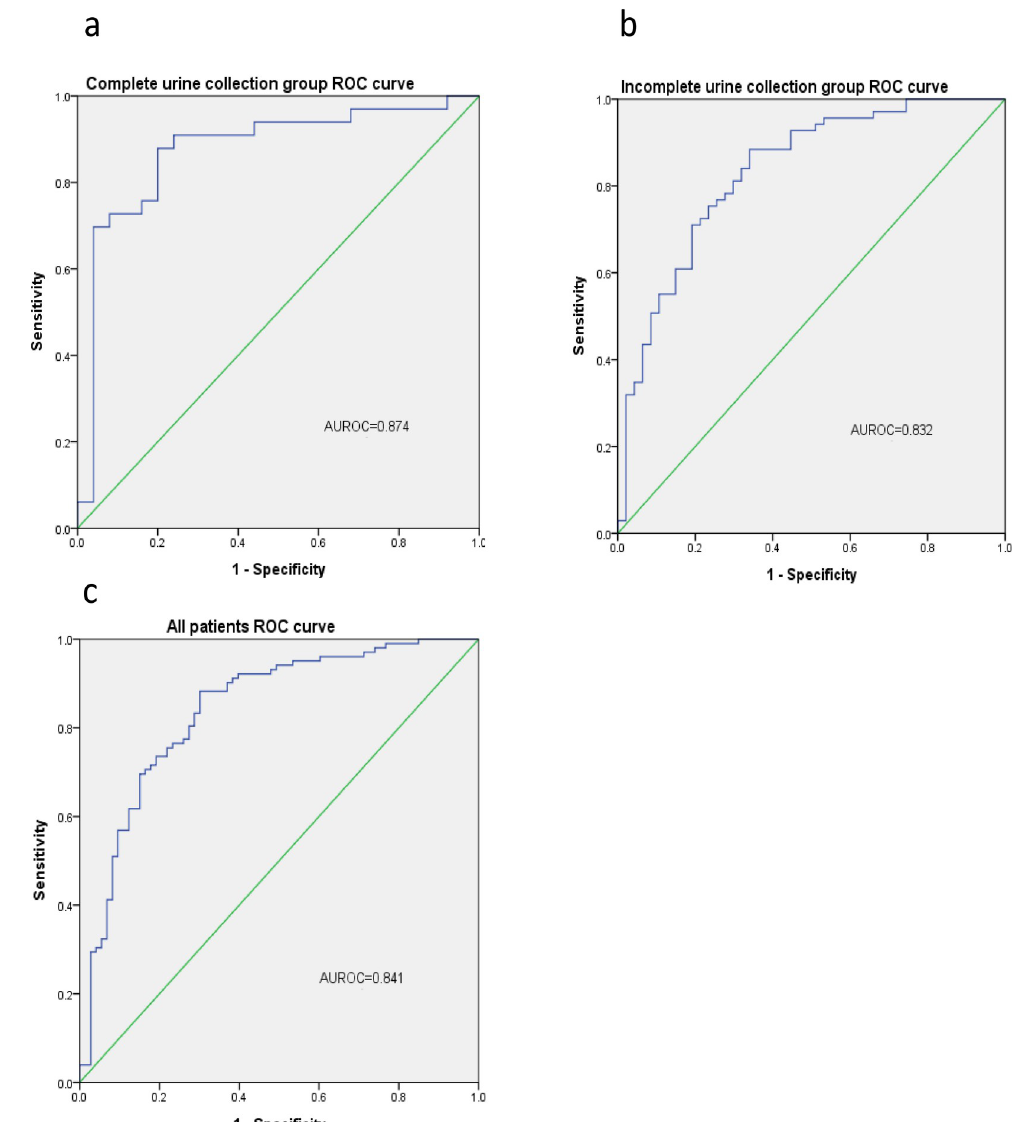
Fig 2. ROC curve of the spot urine sodium (Na)/potassium ratio in predicting 24-h urine Na excretion. a: the complete urine collection group, b: the incomplete urine collection group, c: all patients. Abbreviations: ROC receiver operating